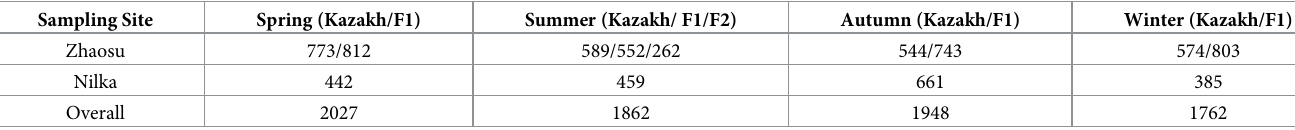
Table 1. Sample collection in Zhaosu and Nilka counties in the four seasons (number of samples). Sampling